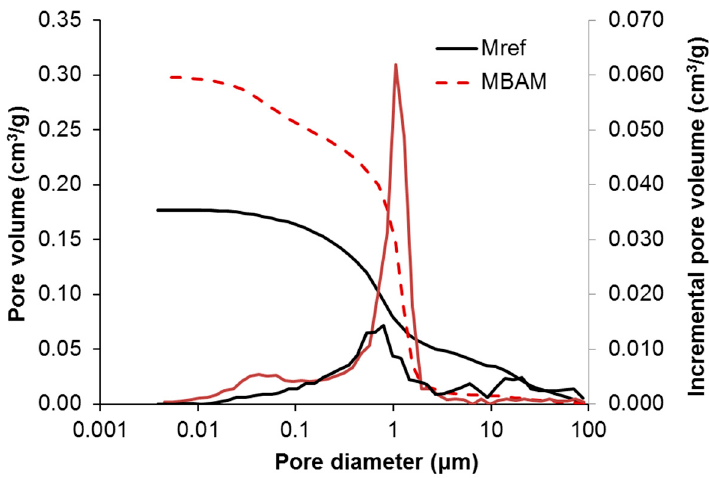
Figure 6. Pore size distribution.